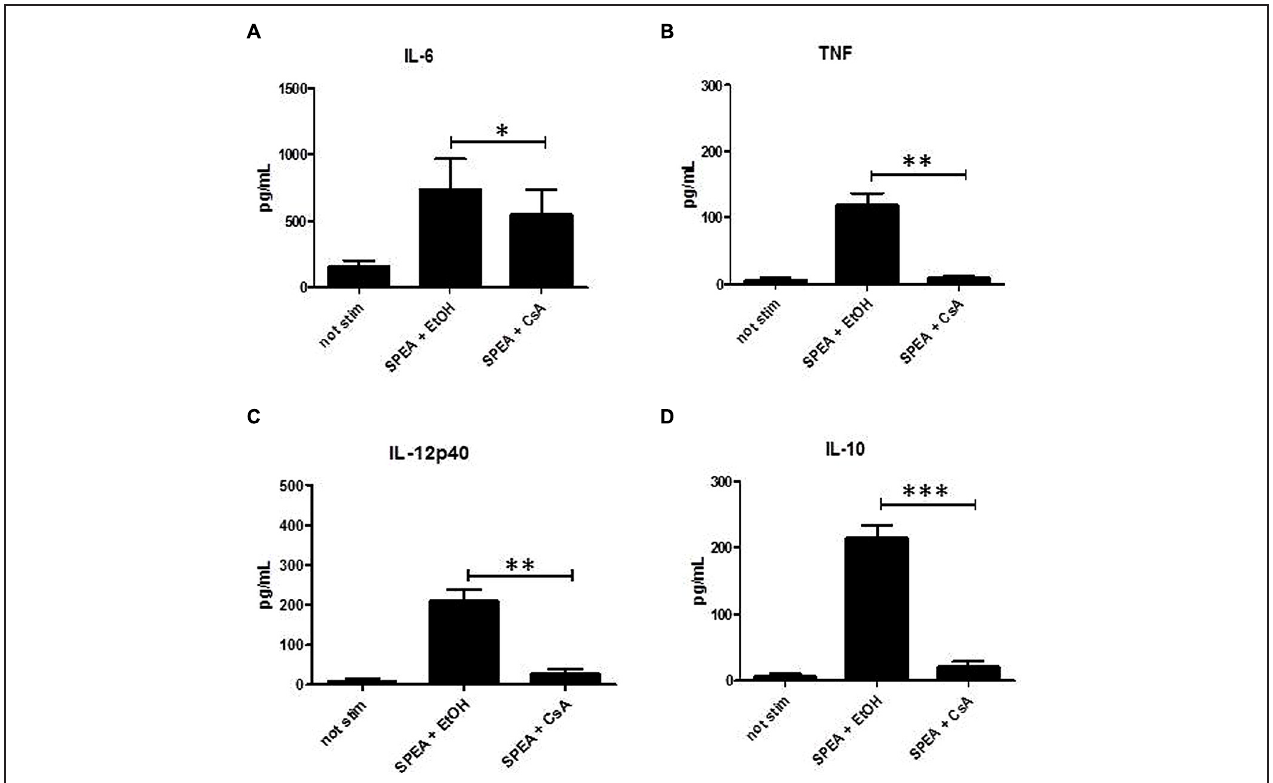
FIGURE 5 | Cyclosporine A (CsA) prevents secretion of cytokines. CD14 + monocytes were stimulated with SPEA (100 ng/ml) and CsA (1 μ M) or Ethanol (equal volume to CsA) for 24 h. Supernatants were harvested and analyzed by ELISA for (A) IL-6, (B) TNF, (C) IL-12p40 and (D) IL-10. Shown is the mean concentration with standard deviation of 5 different donors. Significance codes: 0 ‘ ∗∗∗ ’; 0.001 ‘ ∗∗ ’; 0.01 ‘ ∗ ’ (Tukey